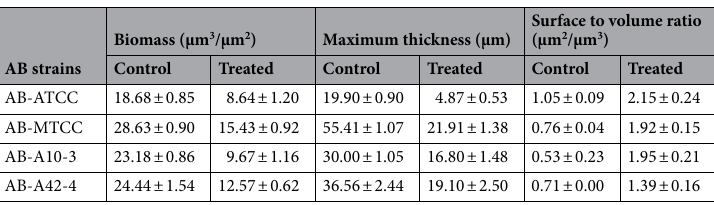
Table 1. Comstat analysis of biofilms formed by AB strains in the absence and presence of myrtenol.